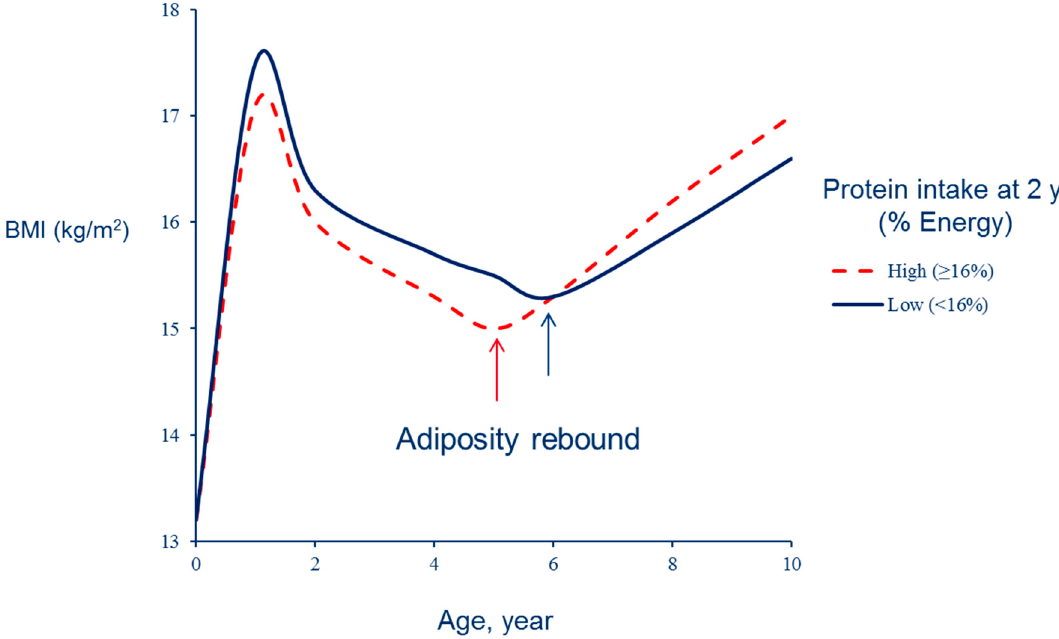
Figure 2. BMI development according to protein intake at 2 years (Etude Longitudinale Alimentation Nutrition et Croissance des Enfants (ELANCE) study) (after [9]).